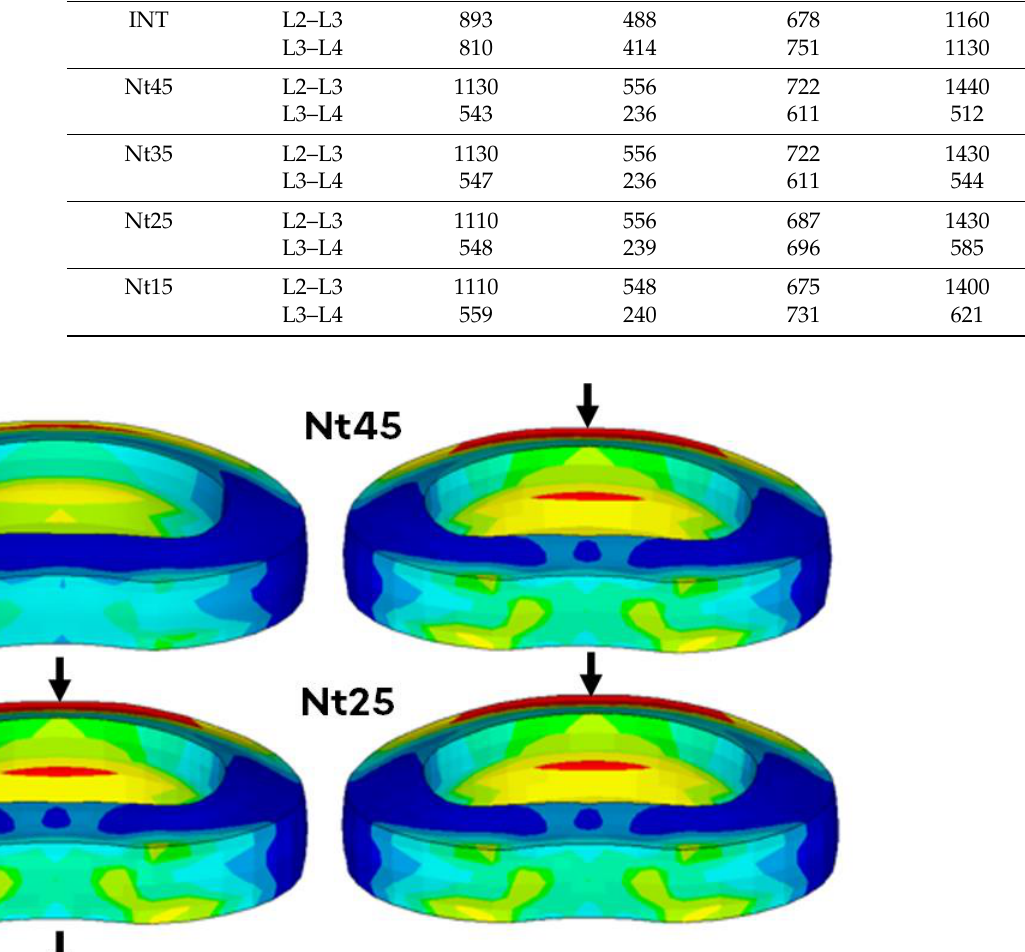
Table 5. Comparison of stress of intervertebral disc (KPa) in finite element models. The von Mises stress on the intervertebral disc. The NS diameter was inversely proportional to the disc stress at the implanted L3–L4 level; it did not markedly influence the disc stress at the adjacent L2–L3 level. Model